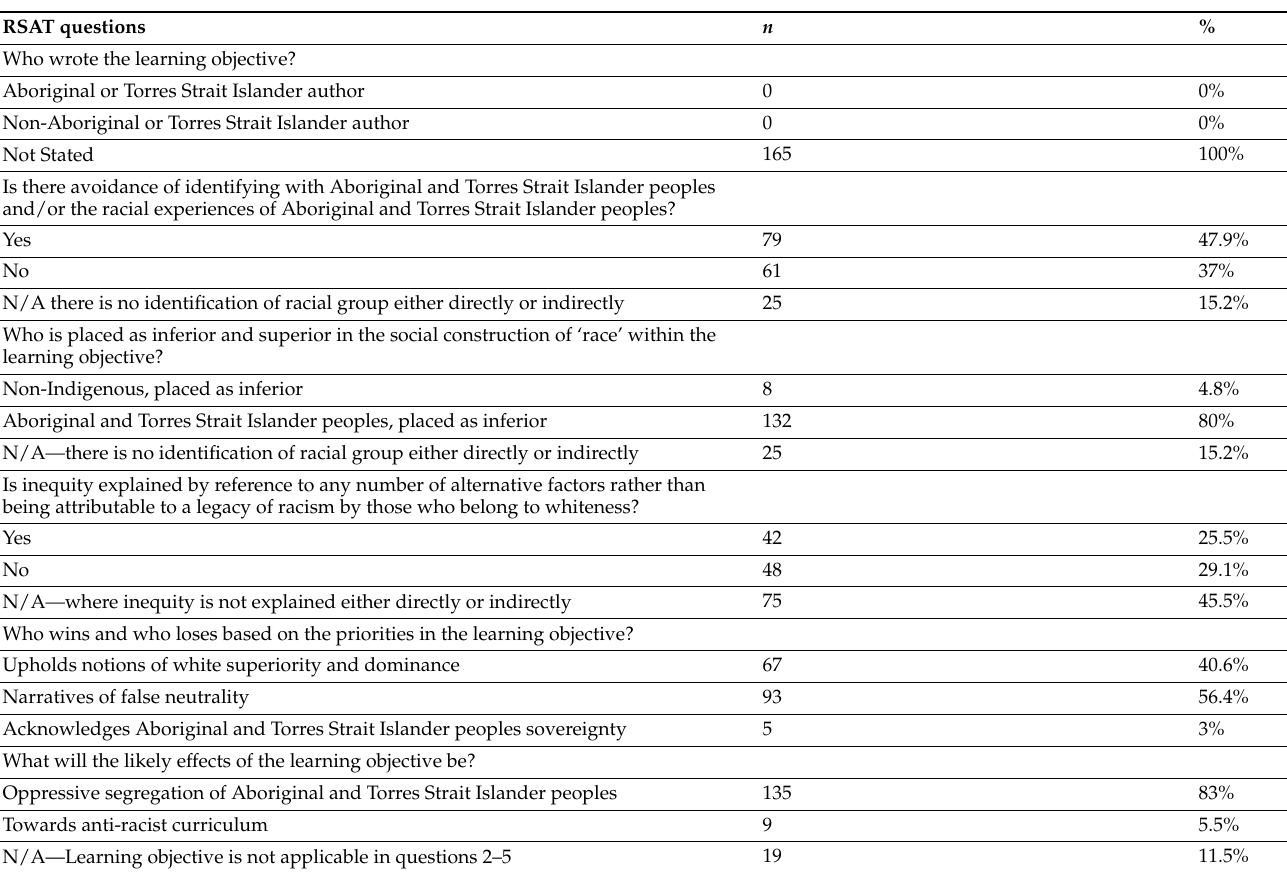
Table 1. RSAT audit of discrete Aboriginal and Torres Strait Islander peoples health courses in undergraduate nursing programs at Australian